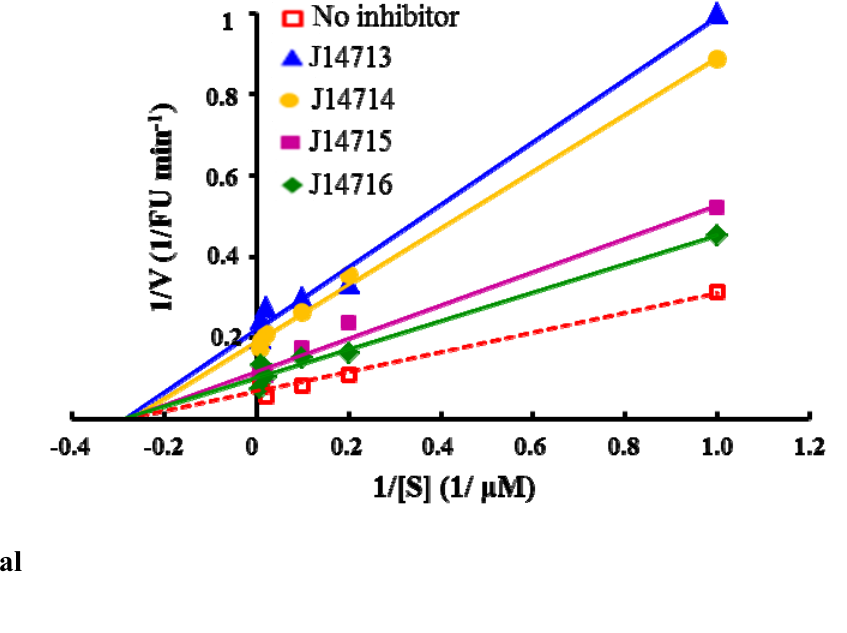
Figure 6. Lineweaver-Burk plots of enzyme kinetics of ADAMTS1 inhibitors. Each inhibitor was tested in triplicate in two independent assays at the concentration of 10 µg/mL. All four compounds only show decrease in V max without a change in K m, indicating noncompetitive